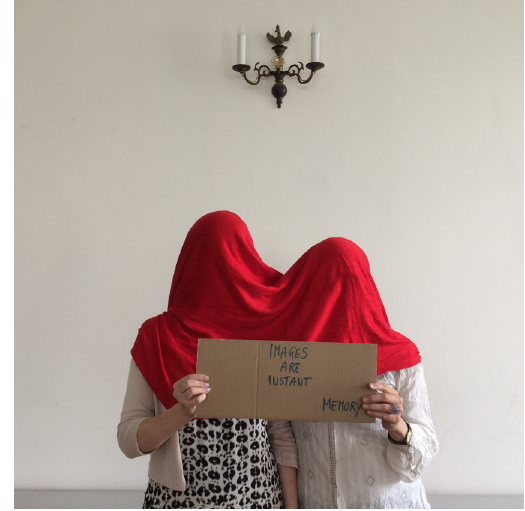
Figure 2. “Wozu Image?”: Images are instant memory